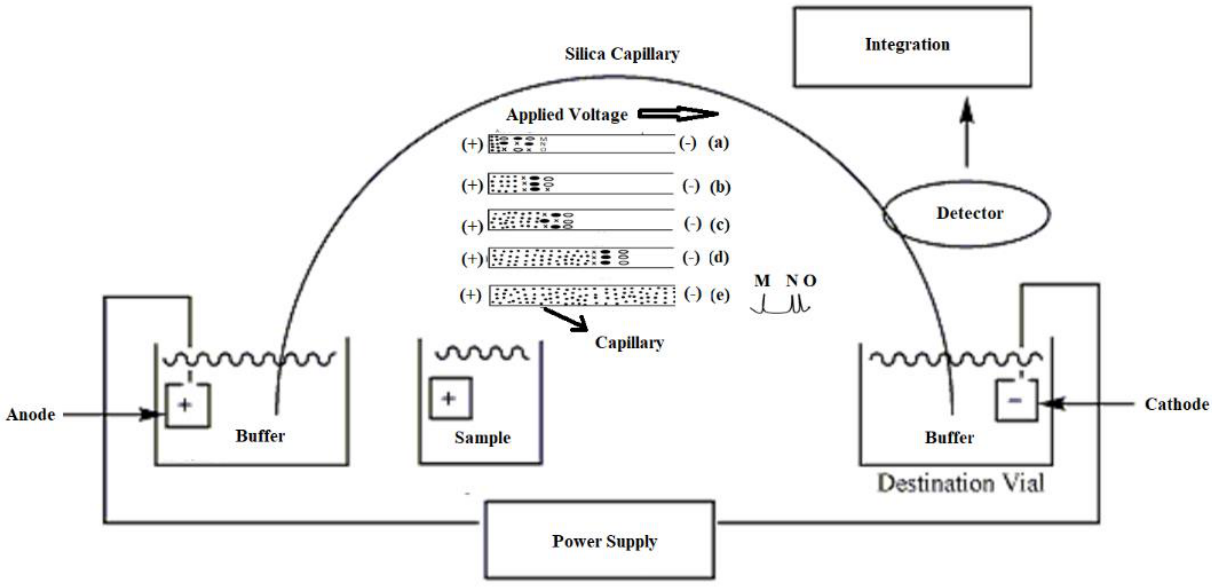
Figure 1. Schematic representation of capillary electrophoresis; a: loading of analytes, b: partial separation, c: some separation of analytes, d: complete separation of analytes and e: elution of ana- lytes.